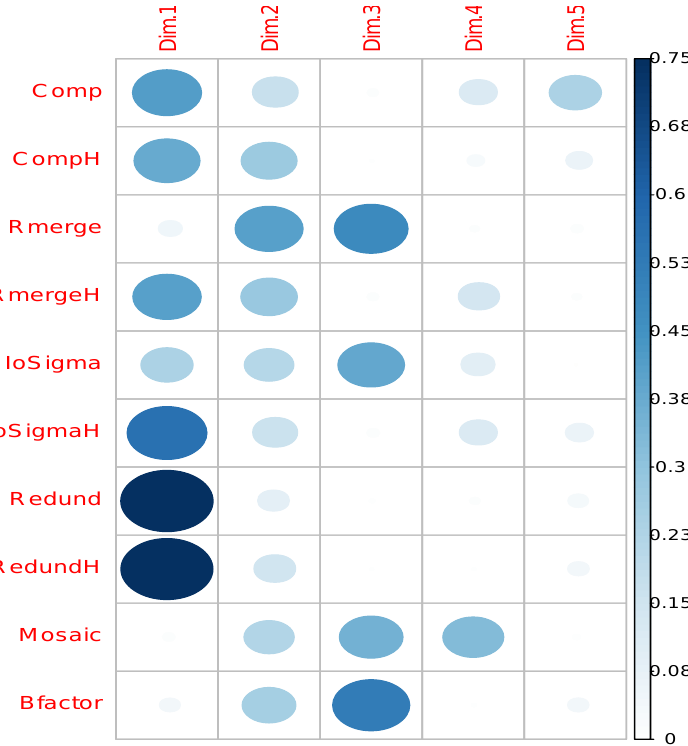
Figure 5. Contribution of each indicator to the five first dimensions.